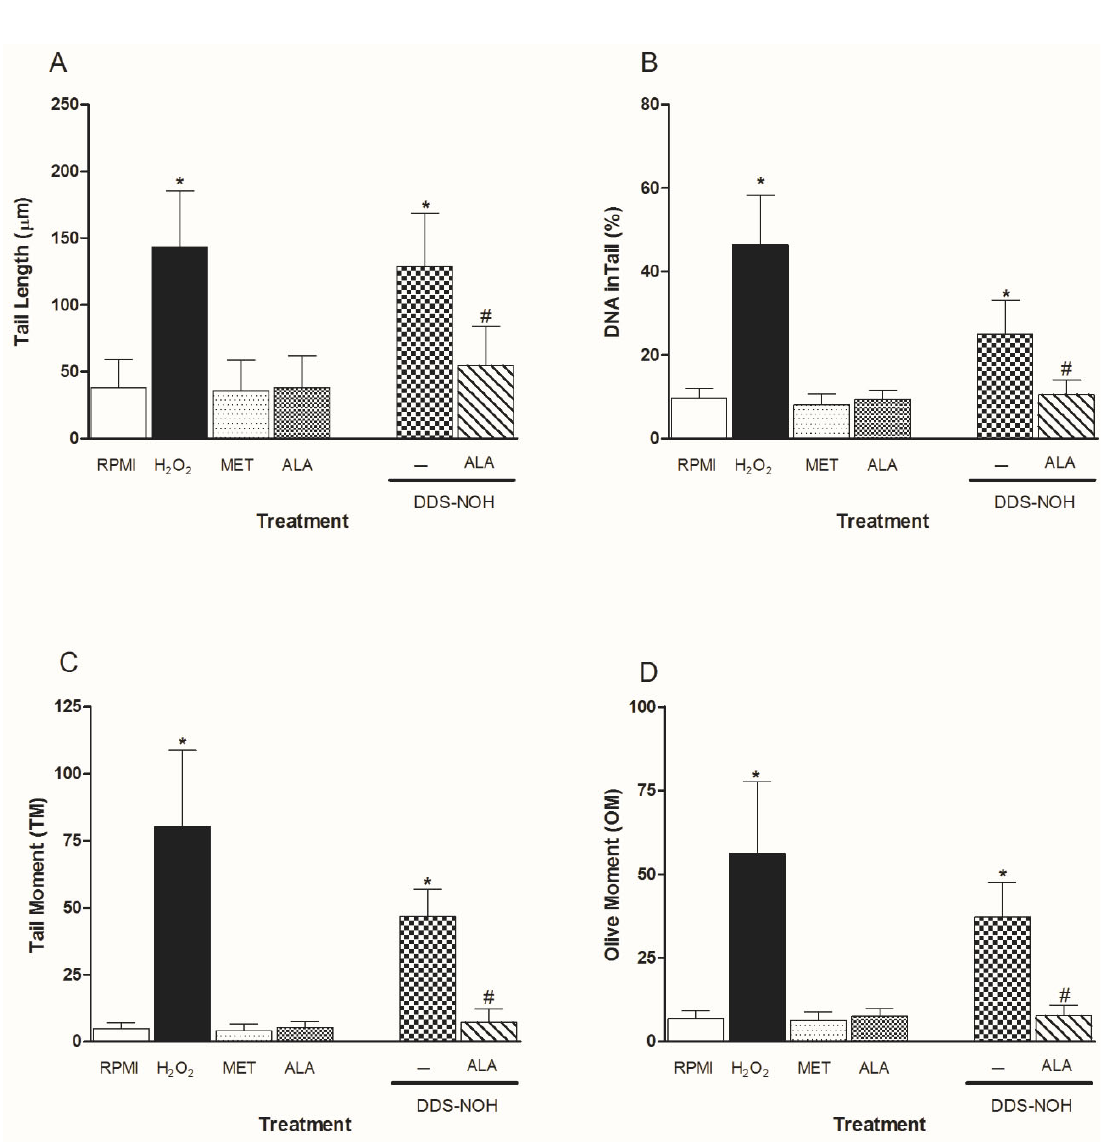
Figure 4. Effect of pretreatment with ALA on DNA damage induced by DDS-NOH. Tail length ( µ m— A ), DNA in tail (%— B ) tail moment (TM— C ) and Olive moment (OM— D ) were used as a marker of DNA damage in lymphocytes using comet assay. Values are means ± S.E.M. * p < 0.05 compared to methanol. # p < 0.05 compared to the DDS-NOH group.